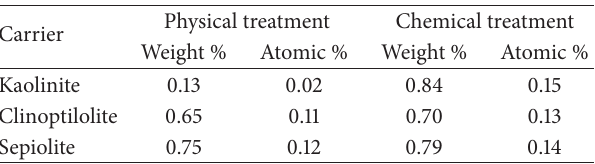
Table 2: Amount of silver incorporated into clays by physical and chemical